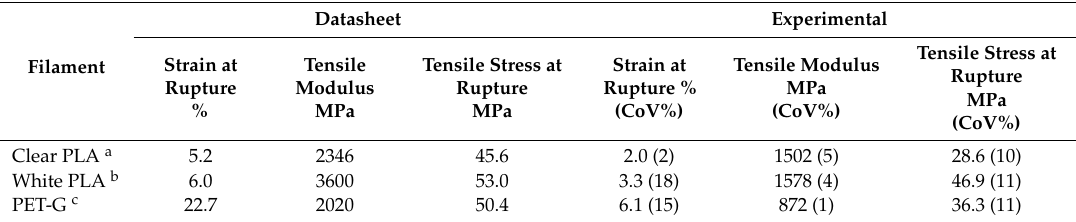
Table A1. 3D printed material properties: elongation at break, tensile modulus evaluation (Coe ffi cients of variation provided in parentheses).